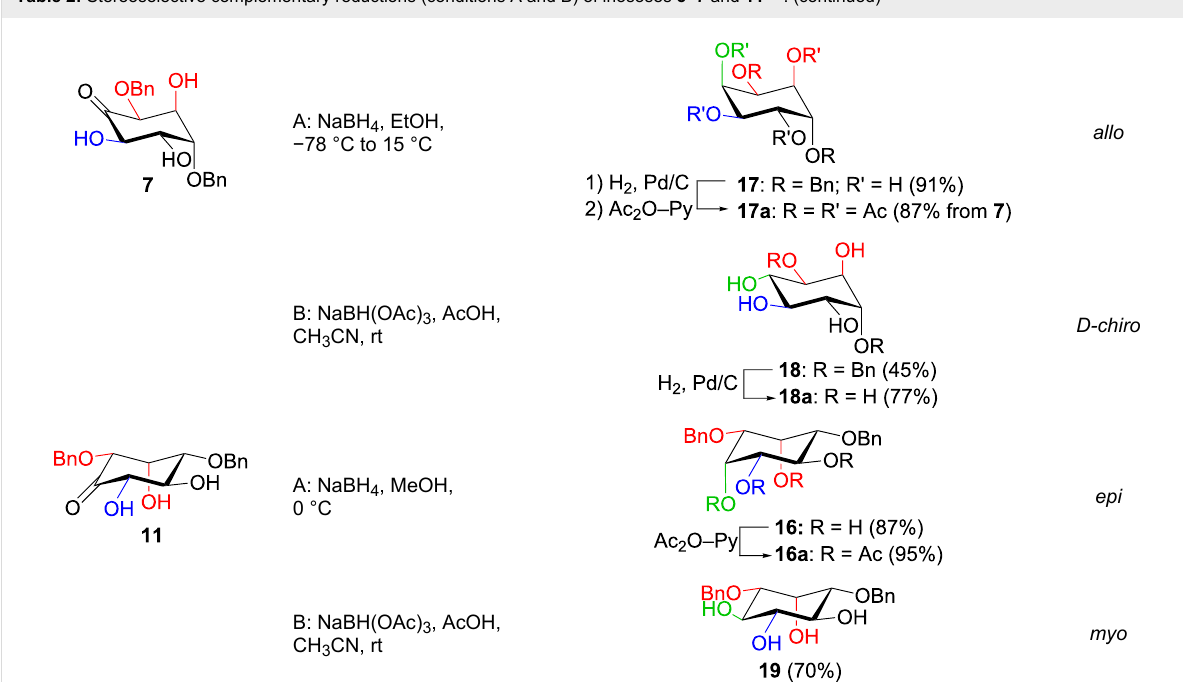
Table 2: Stereoselective complementary reductions (conditions A and B) of inososes 5–7 and 11 a,b . (continued)